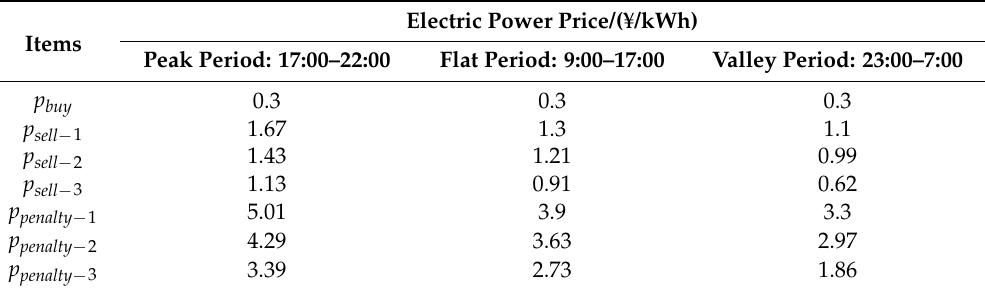
Table 1. The electric power price